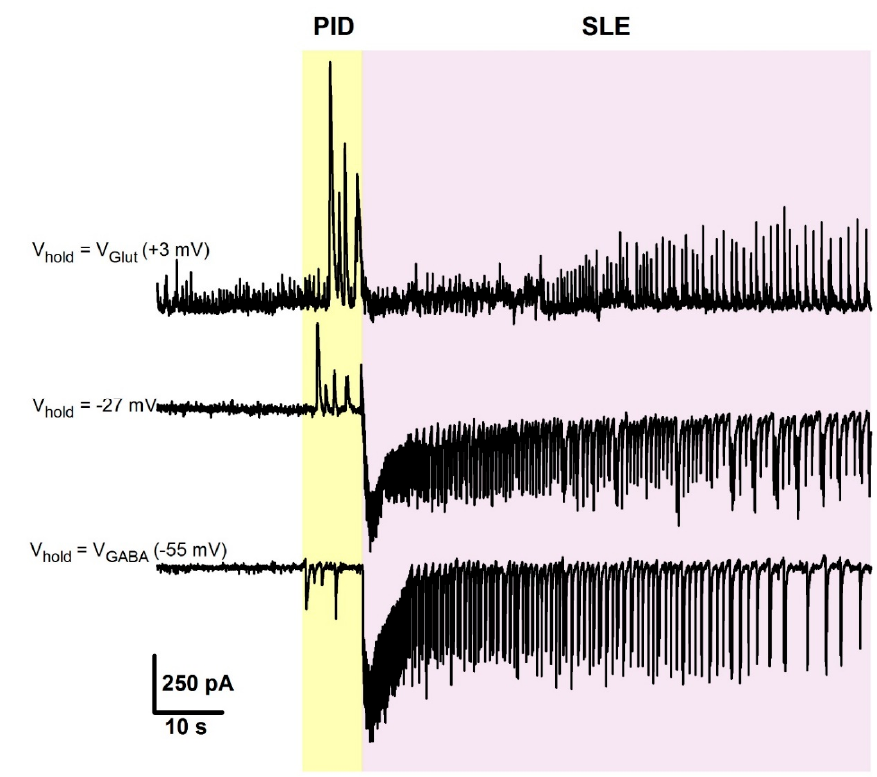
Figure A1. Representative voltage-clamp recordings of synaptic activity during preictal discharges (PIDs) and seizure-like events (SLEs), obtained from the same cell at different holding potentials. Note, that currents corresponding to PIDs and IIDs are reversed at different voltages. At +3 mV, a reversal potential for glutamate-mediated current, only the GABA-mediated component is present and is most prominent during PIDs. At − 55 mV, a reversal potential for GABA-mediated current in these recording conditions, only glutamate-mediated component is present, and during the PID phase, its contribution is low.